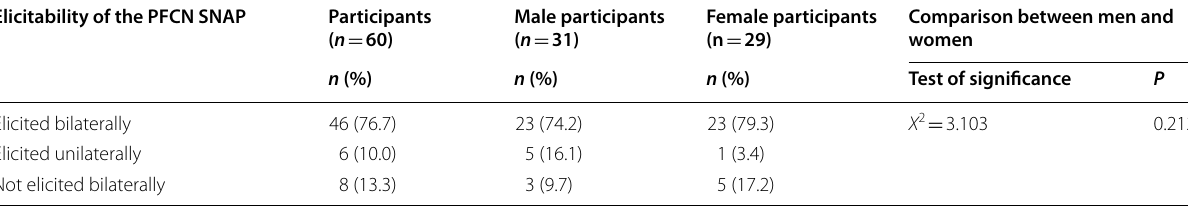
PFCN, posterior femoral cutaneous nerve; SNAP, sensory nerve action potential; n , number of volunteers; n (%) number (percentage); X 2 , value of Chi-square test * Significant when P is < 0.05 Table 3 Cutoff values of the posterior femoral cutaneous nerve sensory nerve action potential parameters